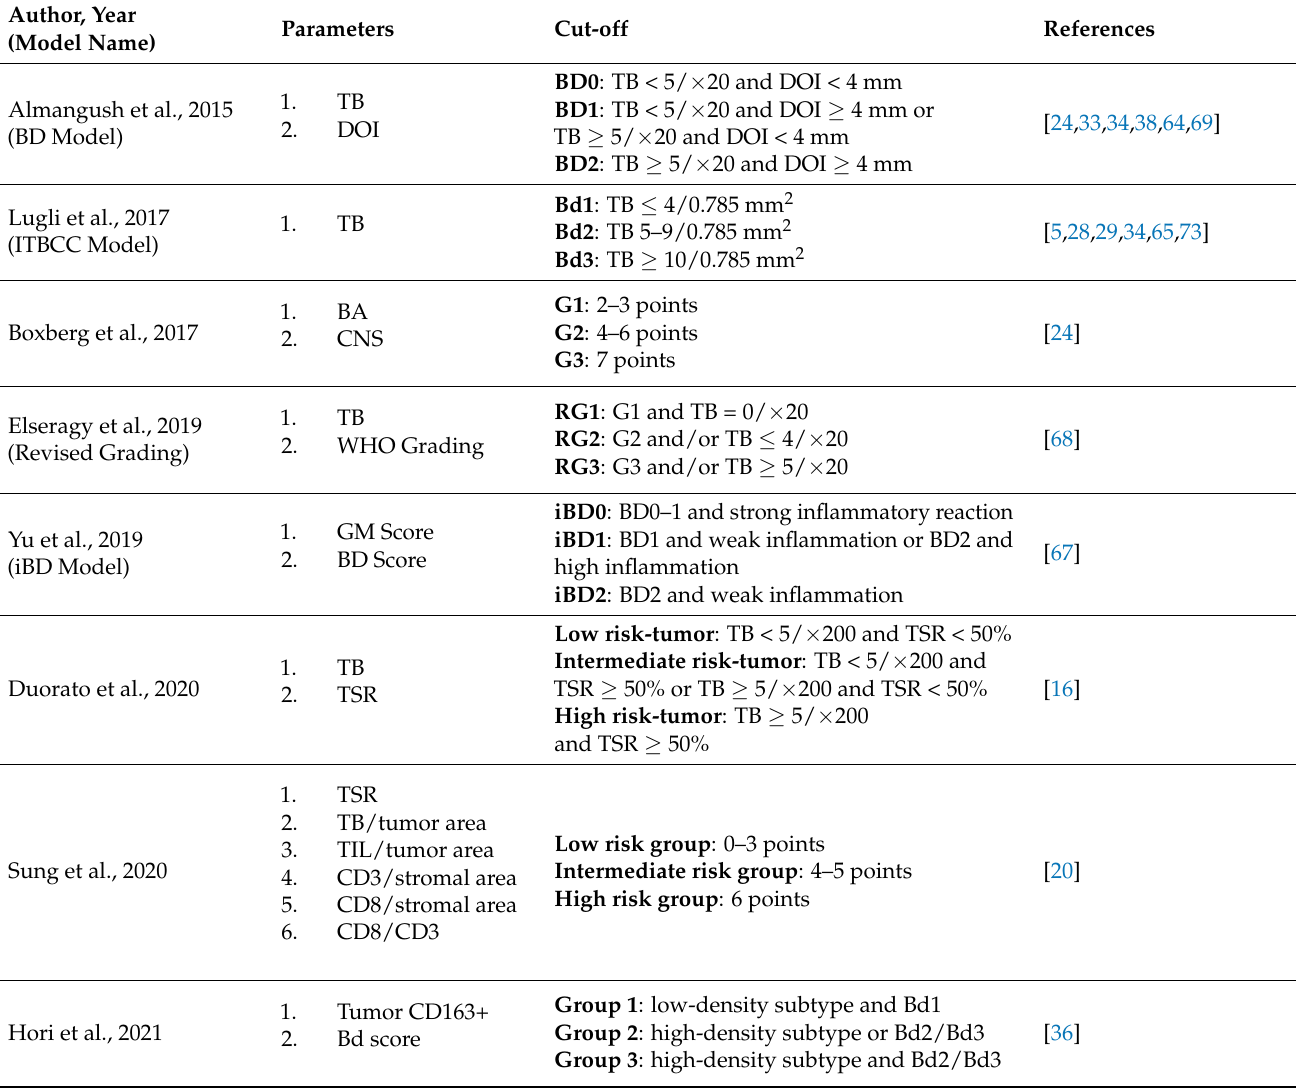
Table 2. Tumor Budding risk models in Oral Squamous Cell